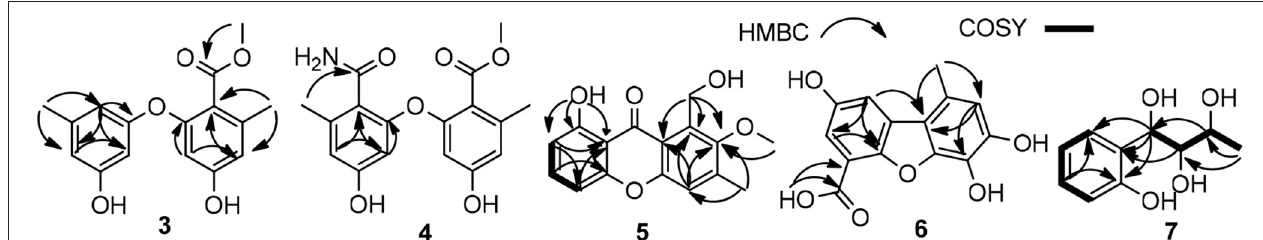
FIGURE 5 | Key COSY and HMBC correlations of 3 – 7